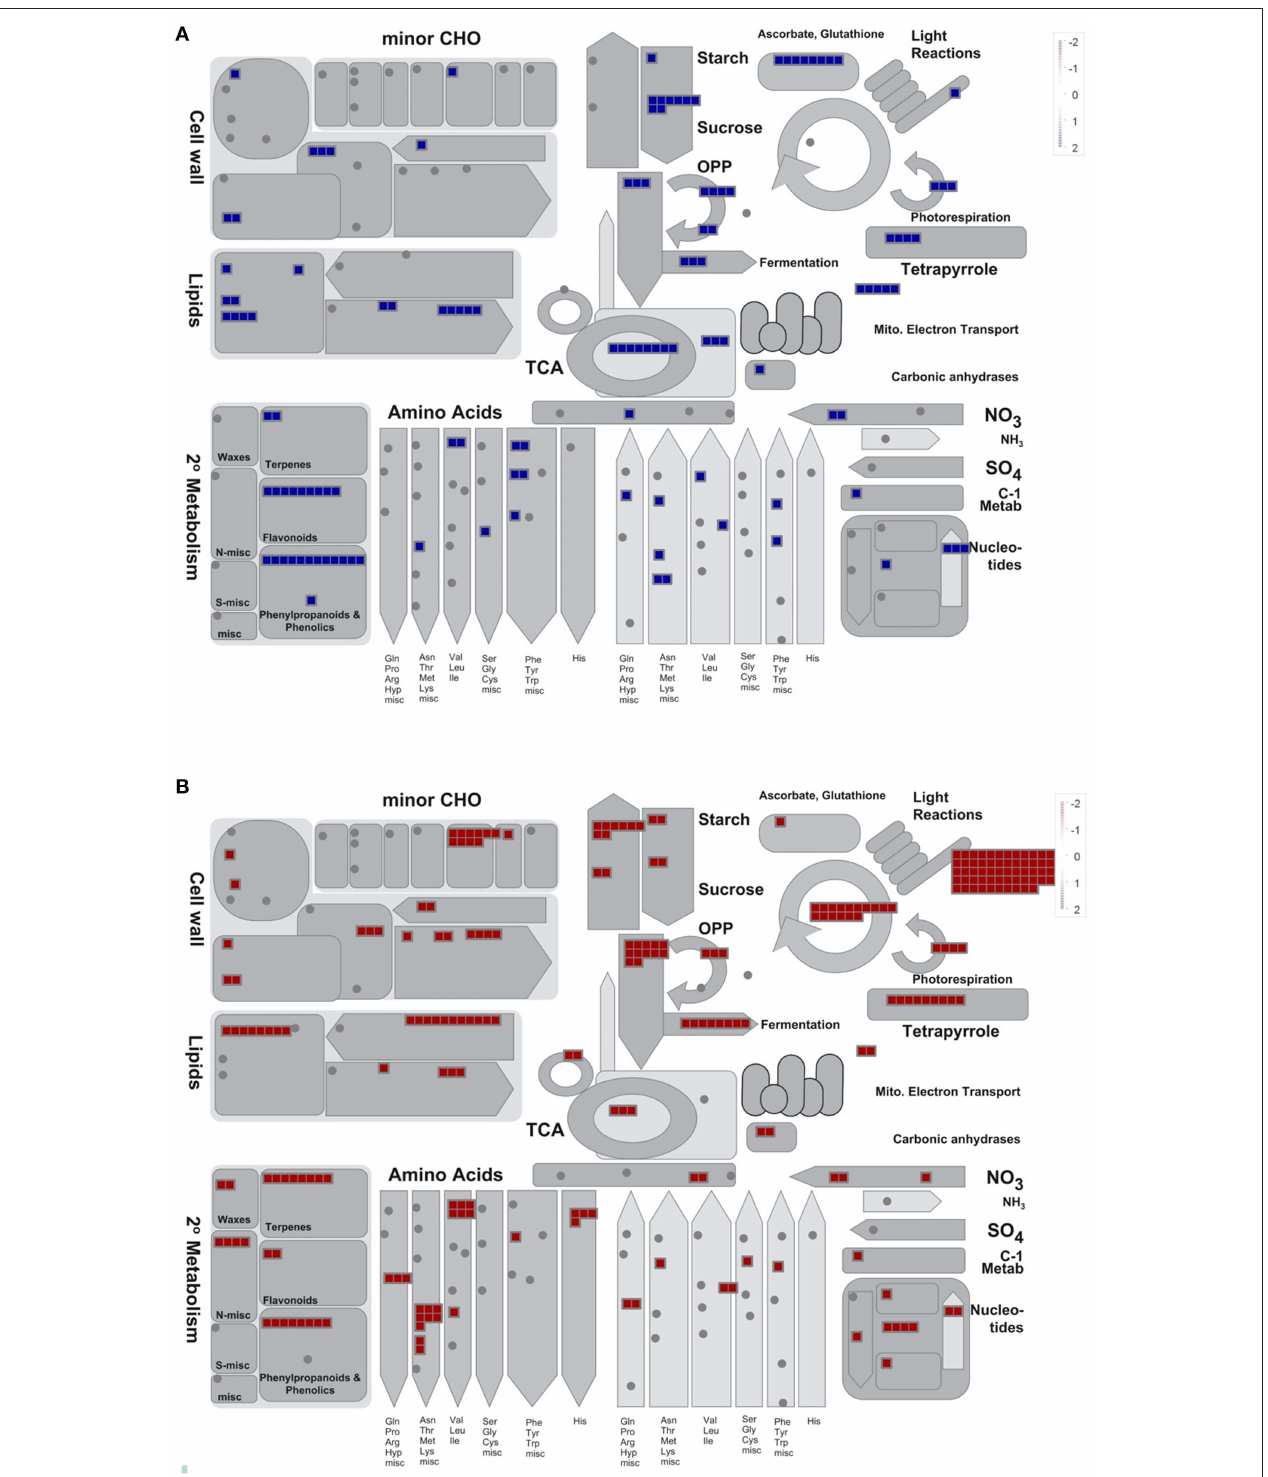
FIGURE 1 | MapMan overview of general metabolism for the gene probesets that were commonly induced or repressed in Ljgln2-2 mutant plants either in drought or in active PR stress conditions. (A) Shows the 1073 gene probesets that were commonly induced by the two types of stress situations and (B) the 957 gene probesets that were commonly repressed analyzed in the context of general metabolism using the MapMan software. Each square represent a gene probeset that changed significantly ( p < 0.05 ) under both types of stress situation. The gene probesets are within a figure that represents the correspondent